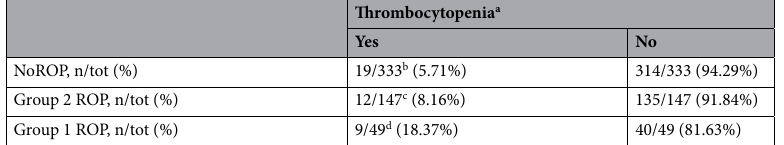
Table 3. Number of cases of thrombocytopenia divided in the three groups: NoROP, Group 1 and Group 2. NoROP premature infants who never developed any form of ROP, Group 2 Type 2 ROP and mild ROPs with self regression of the disease, Group 1 Type 1 ROP and Aggressive posterior ROP that needed treatment, ROP retinopathy of prematurity. Chi-square test, p = 0.0071. a 34 data loss. b 3 data loss in the Group 1 ROP. c 7 data loss in the Group 2 ROP. d 24 data loss in the no-ROP